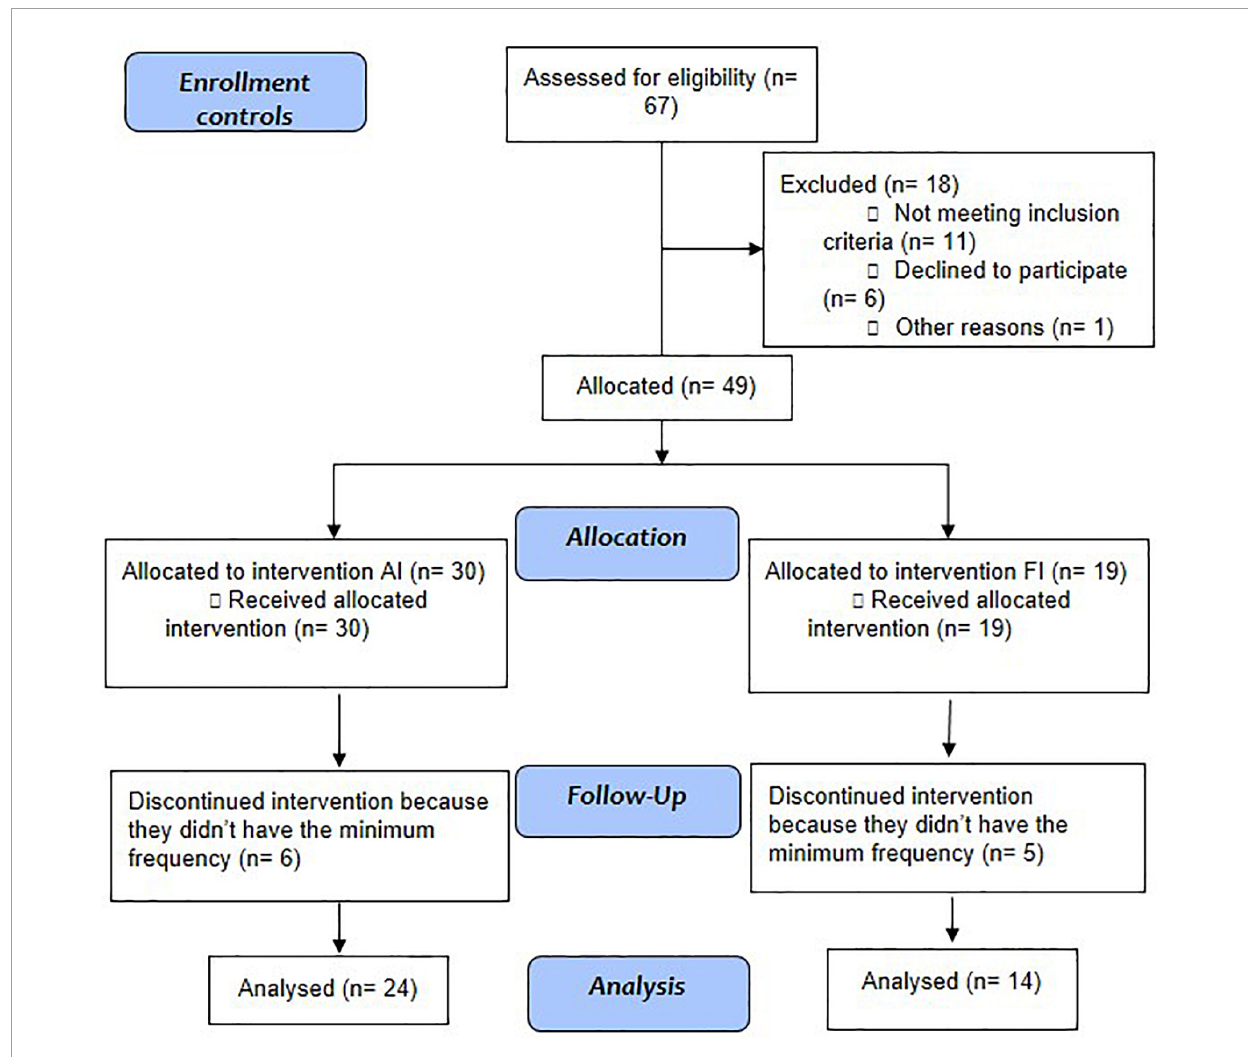
FIGURE2 Study flowchart: Aerobic intervention (AI) and functional intervention (FI) in